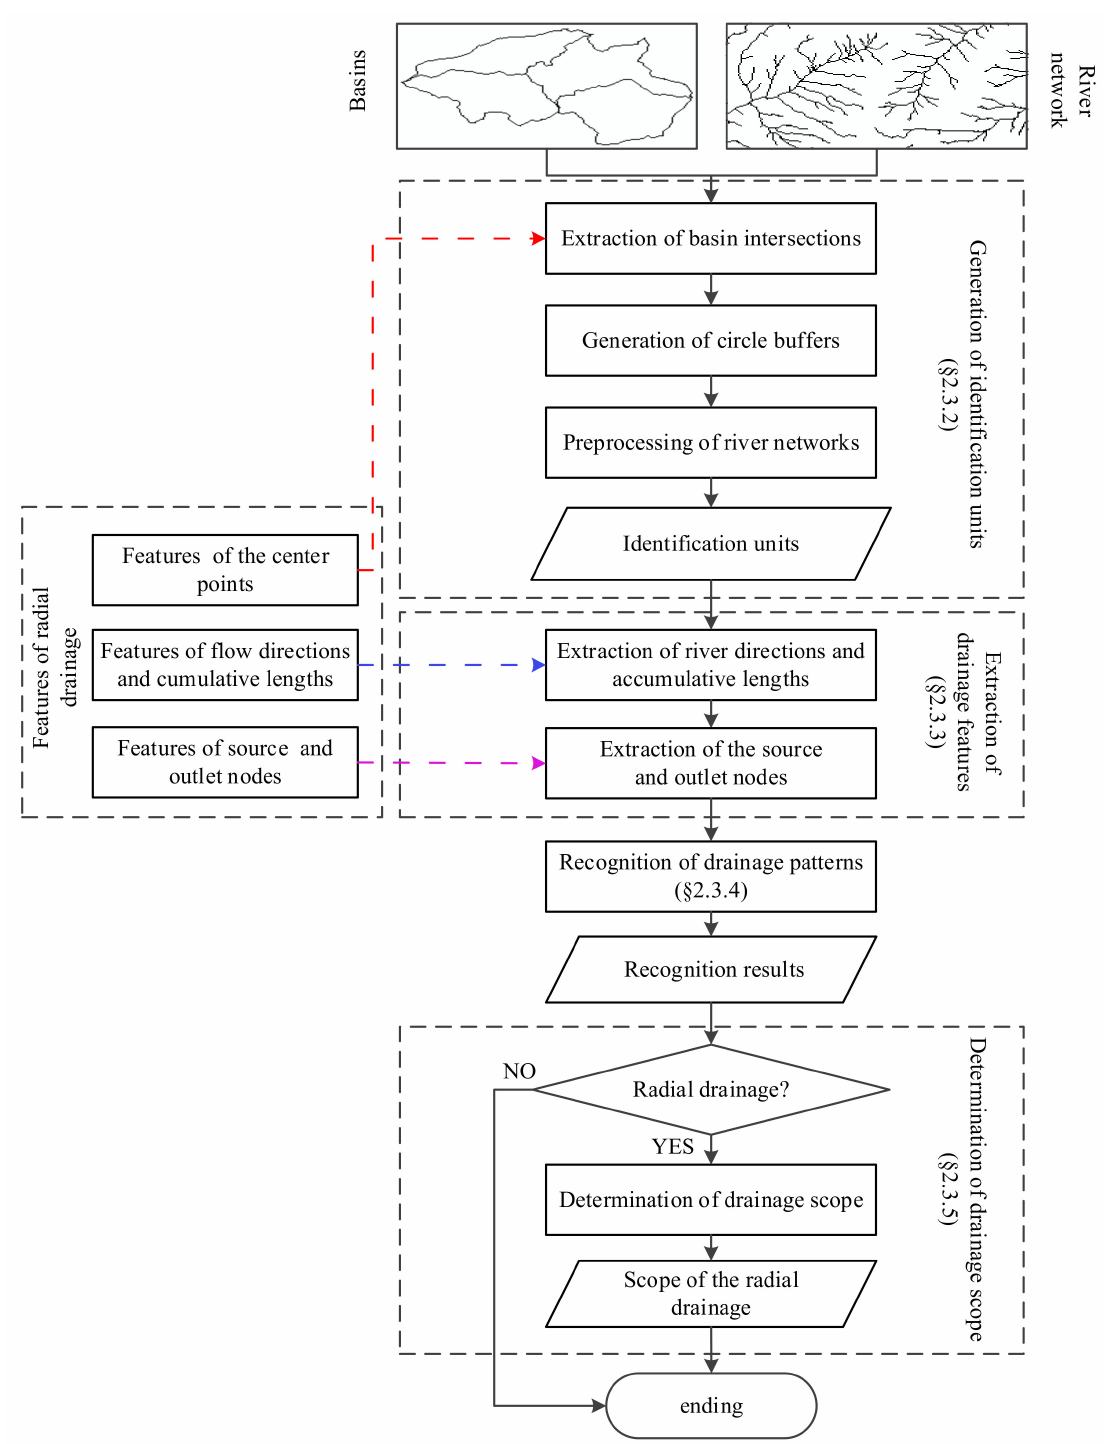
Figure 4. Flow diagram of the RD identification